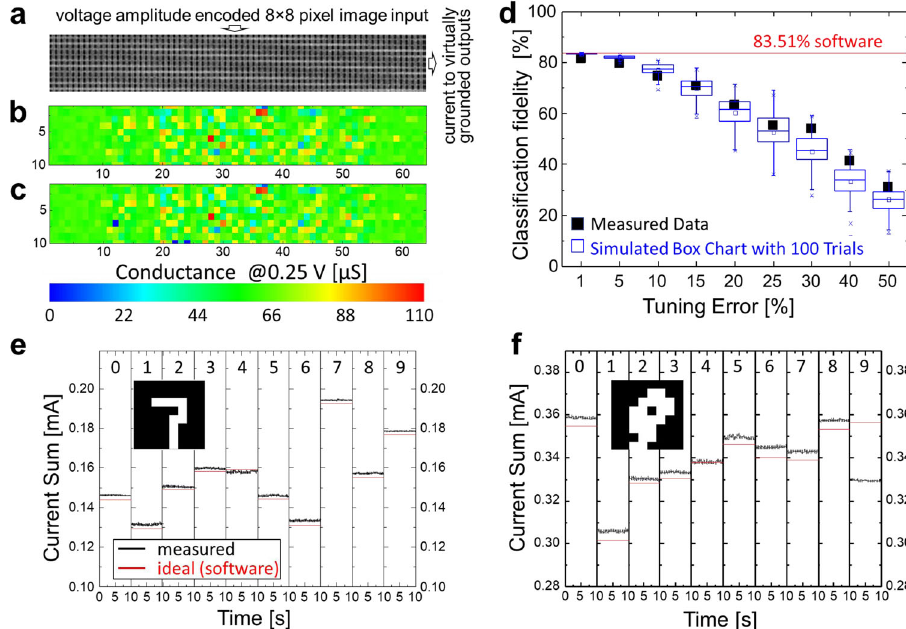
Fig. 4 Experimental results for pattern classi fi cation. a A portion of the crossbar circuit is utilized in a 64 × 10 single-layer perceptron MNIST image classi fi cation experiment. b Examples of target and ( c ) actual conductances after tuning with a 1% relative error. d Measured classi fi cation fi delity and its comparison with simulation results as a function of weight import accuracy. In each simulation trial, the weights are selected randomly from a range of target_value× [1 − tuning_error, 1 + tuning_error]. e , f Measured output currents for all ten outputs over the 10-s interval for patterns ‘ 7 ’ and ‘ 9 ’ (shown in the corresponding insets) for the experiment with a 1% relative tuning error. The currents are measured, one row at a time, by simultaneously applying input voltages on all 64 columns and grounding 10 speci fi ed rows. See Fig. 3 caption for the de fi nition of relative tuning error.